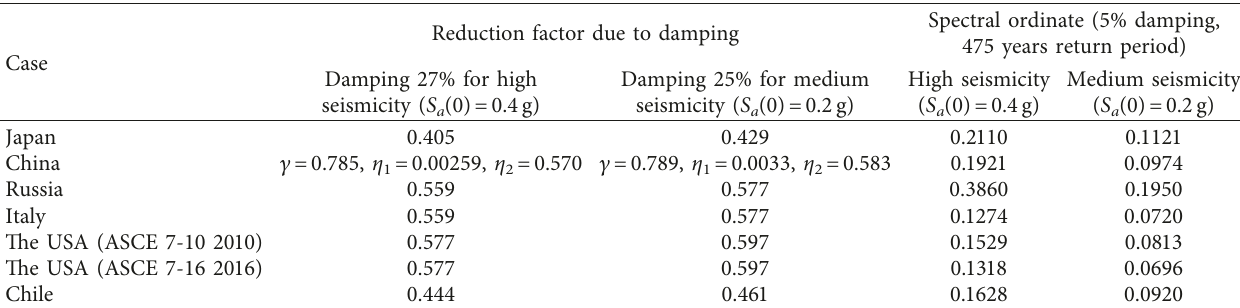
Table 18: Design parameters for static linear analysis of the example hospital